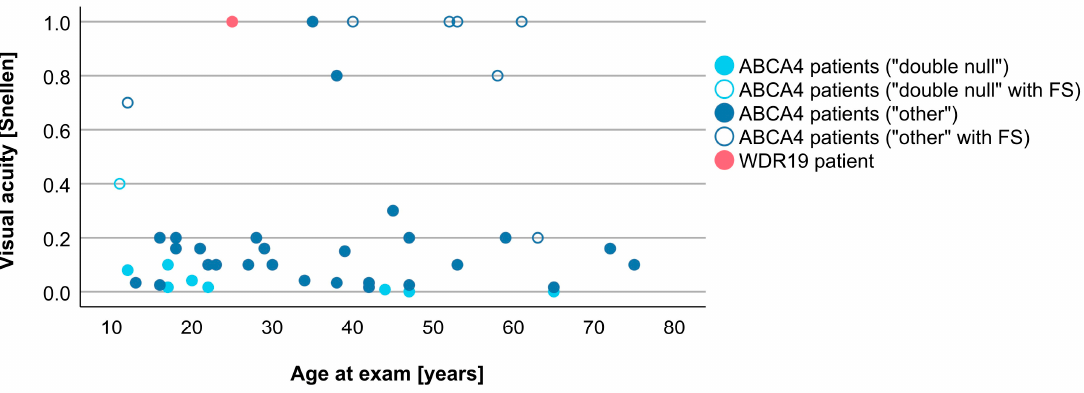
Figure 5. Comparison of VA between WDR19 patient (red), double null ABCA4 patients (light blue) and ABCA4 patients with other genotypes (dark blue). Foveal sparing patients are marked with empty circles. Abbreviation explanation: FS—foveal sparing.